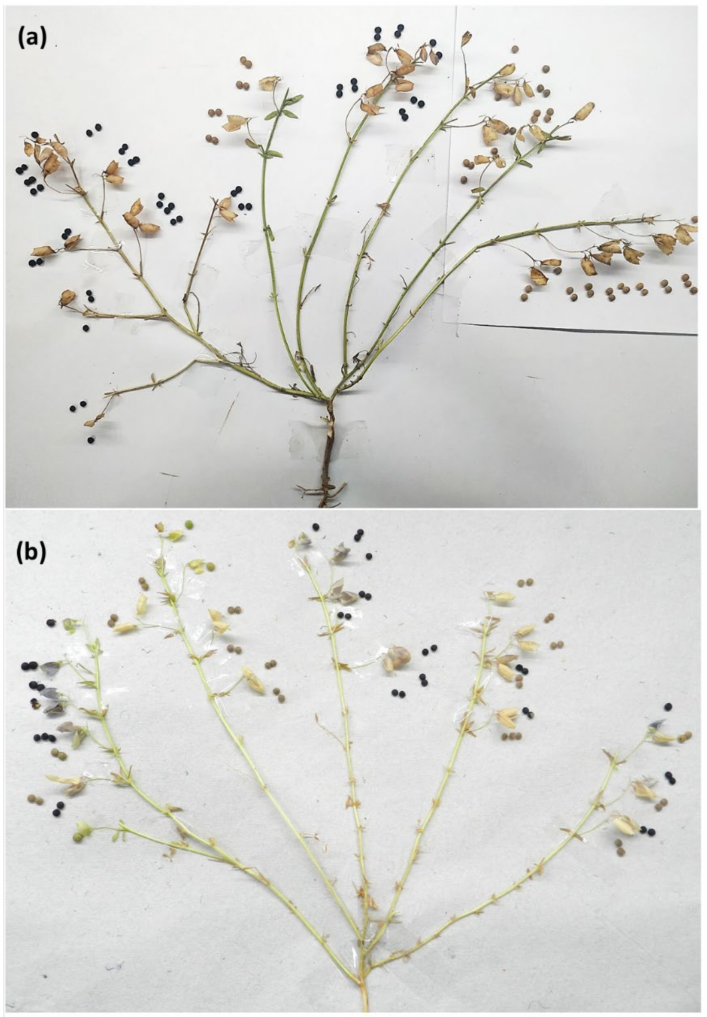
Figure 8. A representative picture of a lentil plant (L4717-NM) showing ( a ) both black and brown seed-coat colored lentil seeds in different branches; ( b ) both black and brown seed-coat colored lentil seeds in the same branch (different